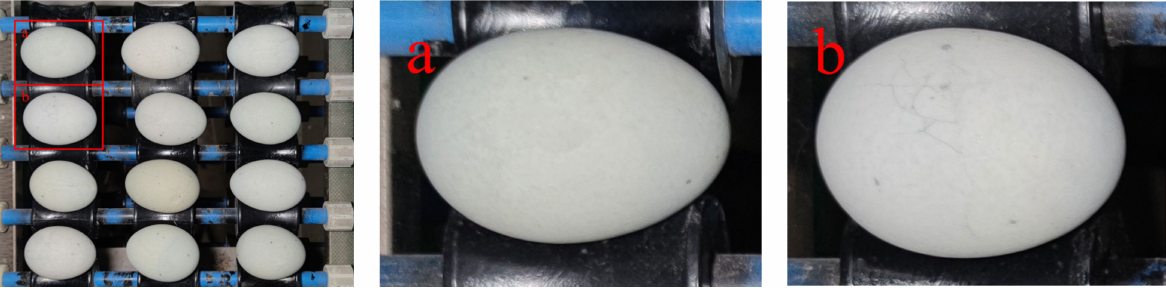
Figure 1. Preserved egg sample image. ( a ) denotes preserved egg; ( b ) denotes creaked preserved